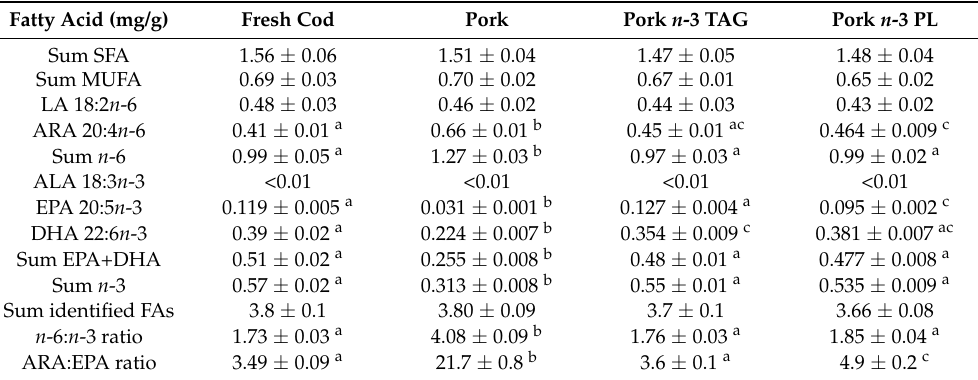
Table 3. Fatty acid composition in red blood